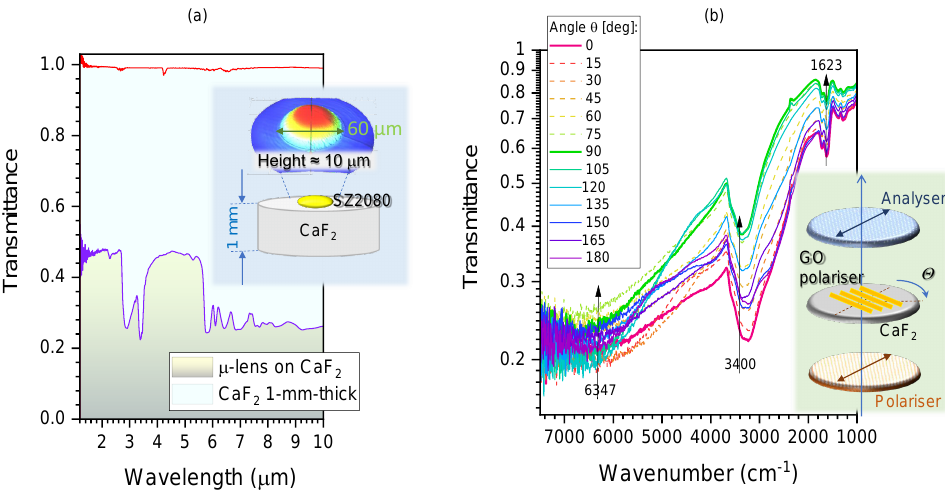
Figure 6. ( a ) IR transmittance spectra of the fabricated GO polariser measured by a microscope FTIR spectrometer with a parallel polariser–analyser. ( b ) Transmittance and the fitted formulae of the contributions from absorbance and the retardants at 1.58, 2.94, and 6.16 µ m, as marked in the transmittance spectra. Note that T is plotted on a logarithmic scale to better reveal any small changes. At 3530 and 1080 cm − 1 , C-OH vibrations are present